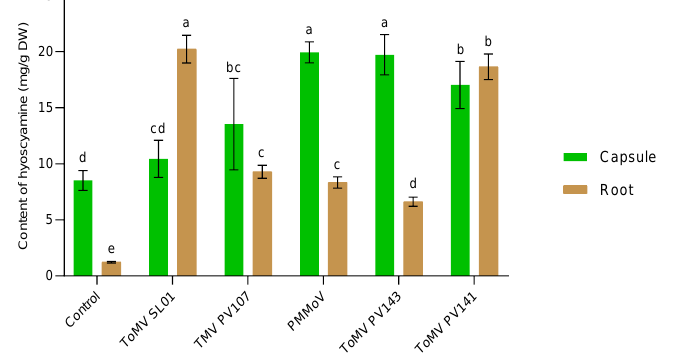
Figure 1. Content of hyoscyamine in capsules and roots of control and elicited plants of D. stramonium . Different superscript letters indicate a significant difference at p < 0.05.